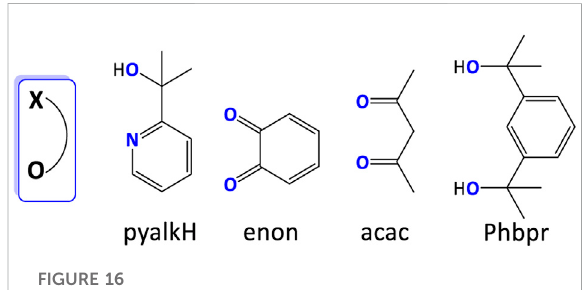
FIGURE 16 Selected O-containing ligands discussed in this review. Coordinating atoms are labeled in